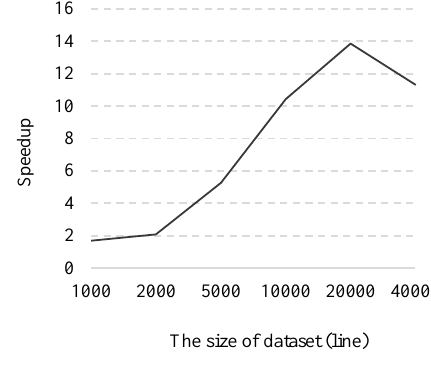
Figure11. Speedup for different size of dataset in similarity and Laplacian matrix